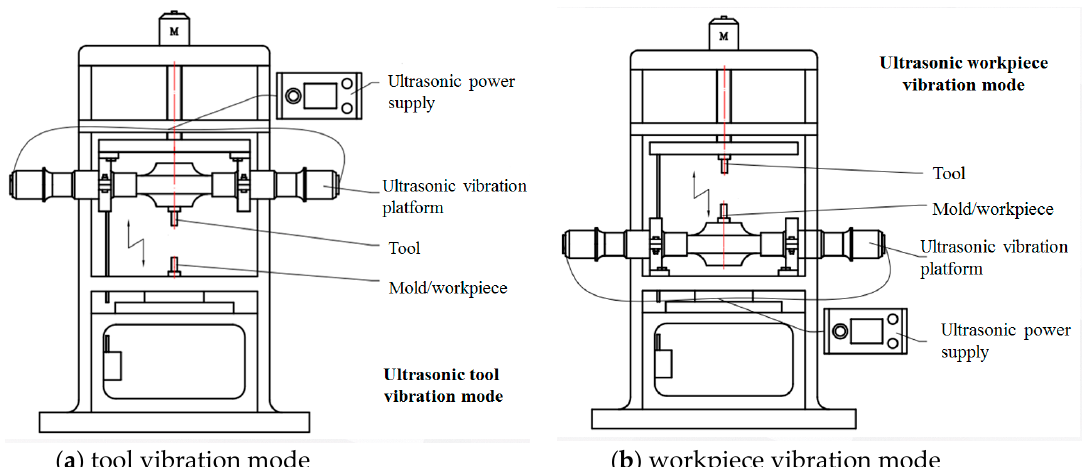
Figure 2. The scheme diagram of ultrasonic plastic forming press machine with different vibration Figure modes.